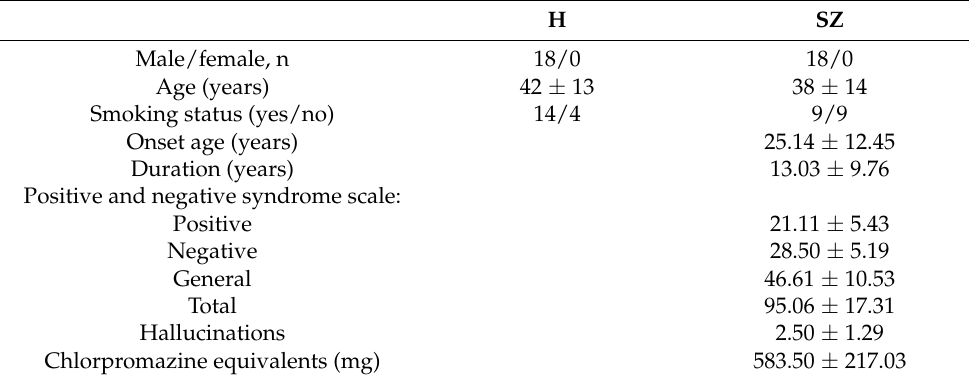
Table 1. Demographic and clinical characteristics of the study